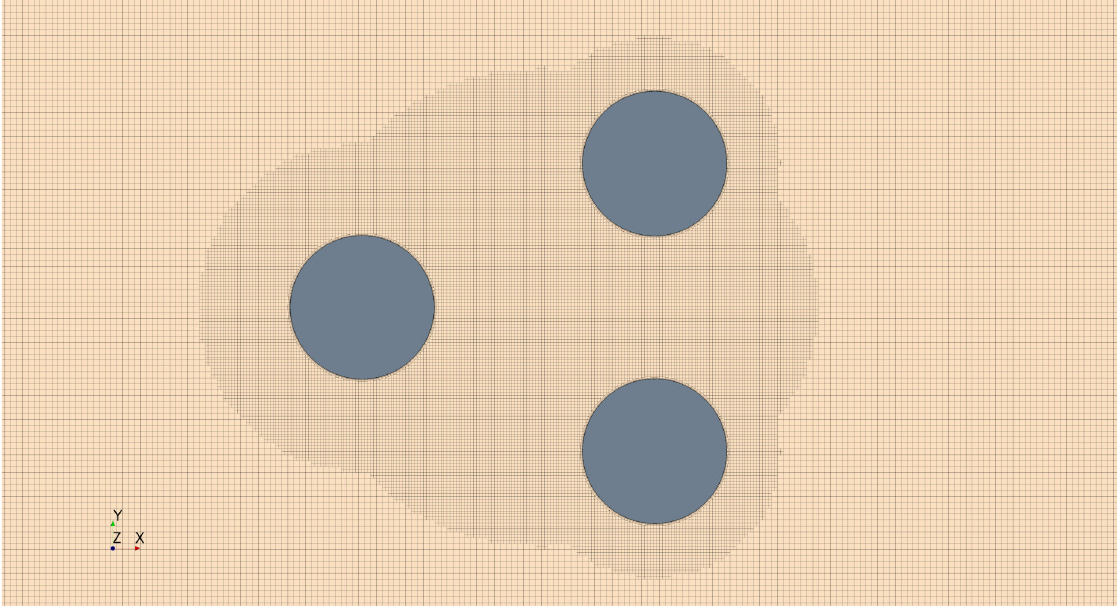
Figure 3. Top view of grid refinement in the vicinity of the large cylinders in the tripod configuration at z = 0 m.